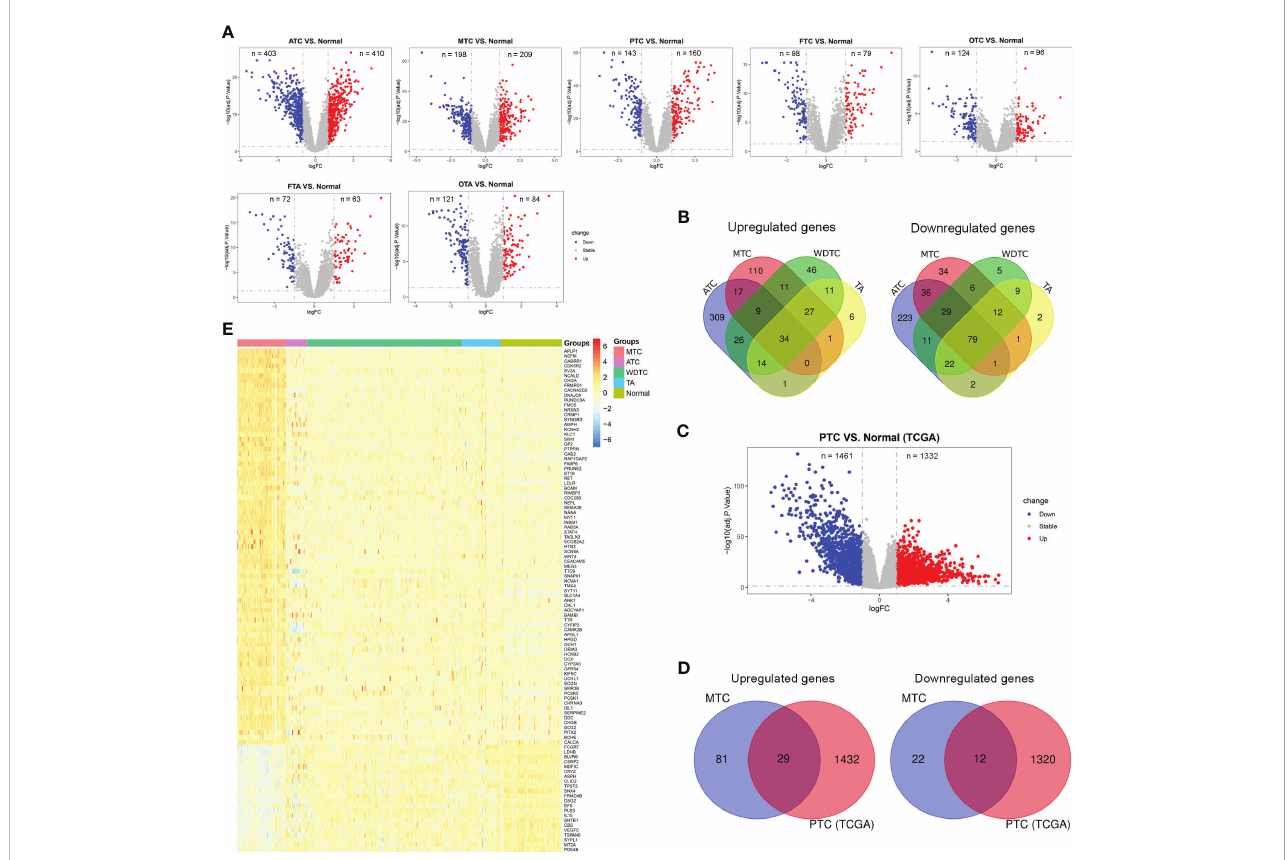
FIGURE 2 Identi fi cation of differentially expressed genes (DEGs) exclusive for MTC. (A) DEGs between thyroid carcinoma subtypes and normal thyroid tissue based on the combined dataset from GEO. (B) The intersection of DEGs among thyroid carcinoma subtypes based on the combined dataset from GEO. (C) DEGs between PTC and normal thyroid tissue based on the TCGA-THCA dataset. (D) The intersection of DEGs between MTC from GEO and PTC from TCGA. (E) The expression levels of 103 MTC-speci fi c DEGs in the combined dataset. ATC, anaplastic thyroid carcinoma; MTC, medullary thyroid